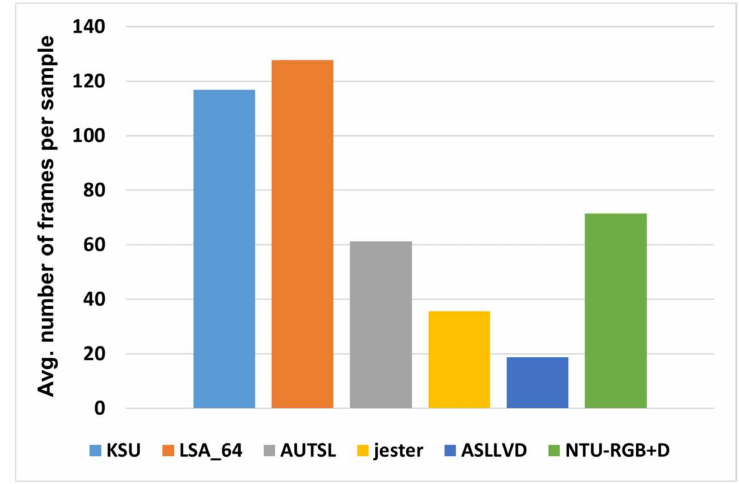
Figure 2. Average video length in different datasets.